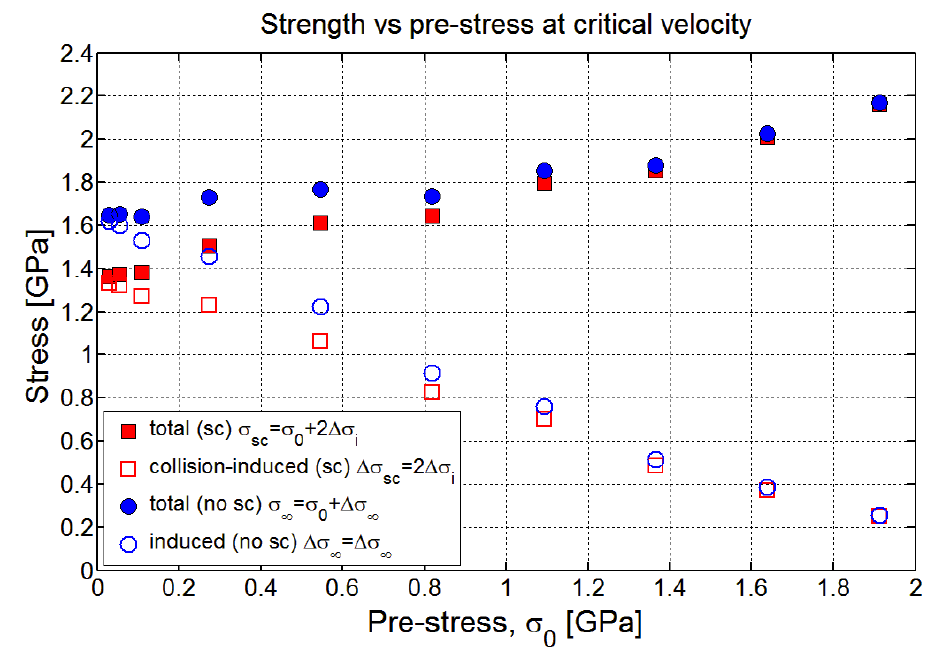
Figure 12. Calculated strength versus pre-stress and critical velocity for the two projectile types. ‘sc’ denotes the flat RCC (reverse-fired fragment simulating projectile (FSP)) case while ‘no sc’ refers to the saddle projectile.